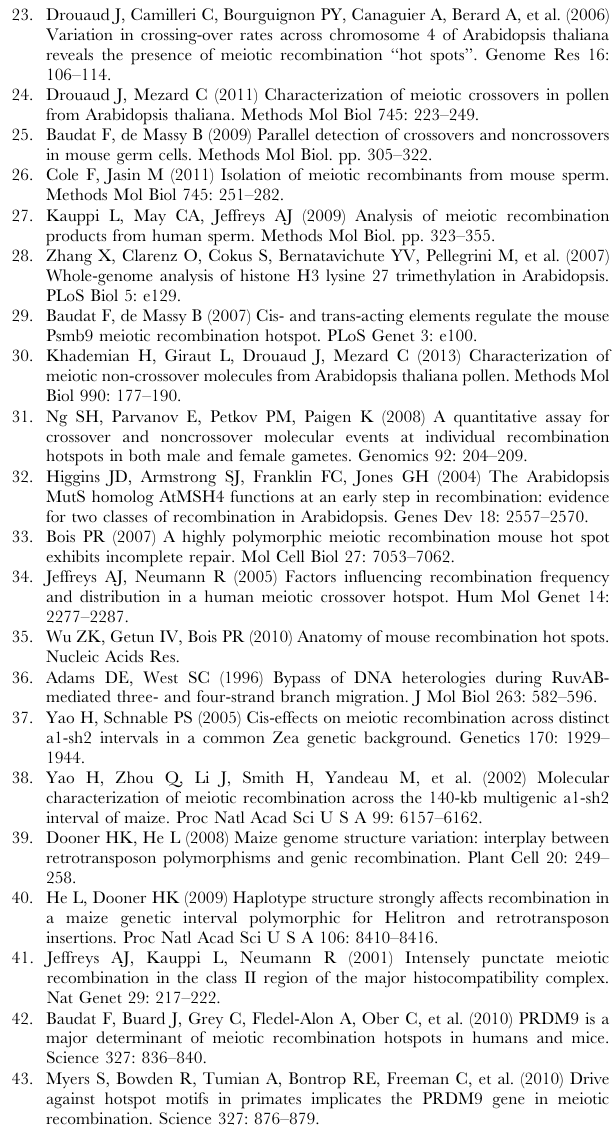
Table S3 Primers for NCO detection at 130 6 . Table S4 Primers for NCO detection at 14a1